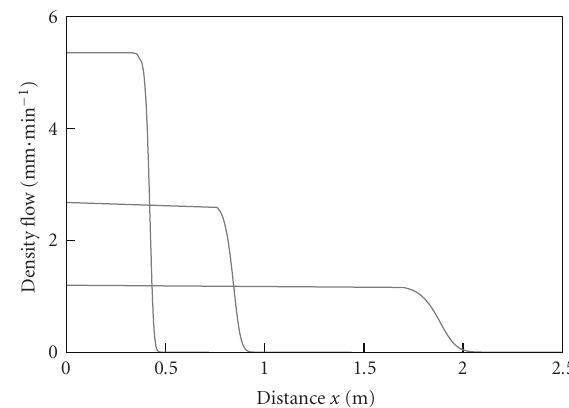
Figure 3: The water density flow as a function of x inside the soilfor times t 1 , t 2 , and t 3 equal to 15, 60, and 300min (from up to down), after (49a) or (49b).